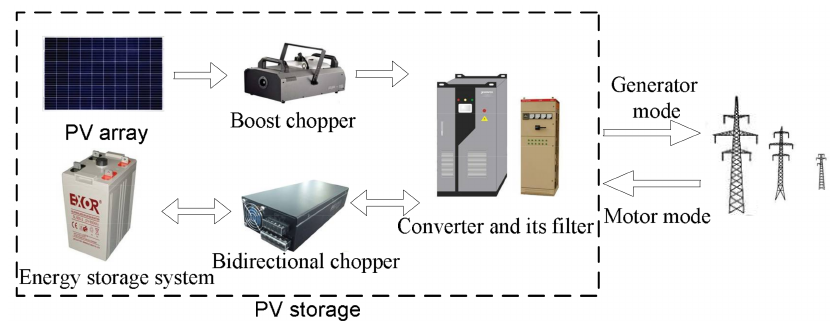
Figure 9. Structure of PV storage